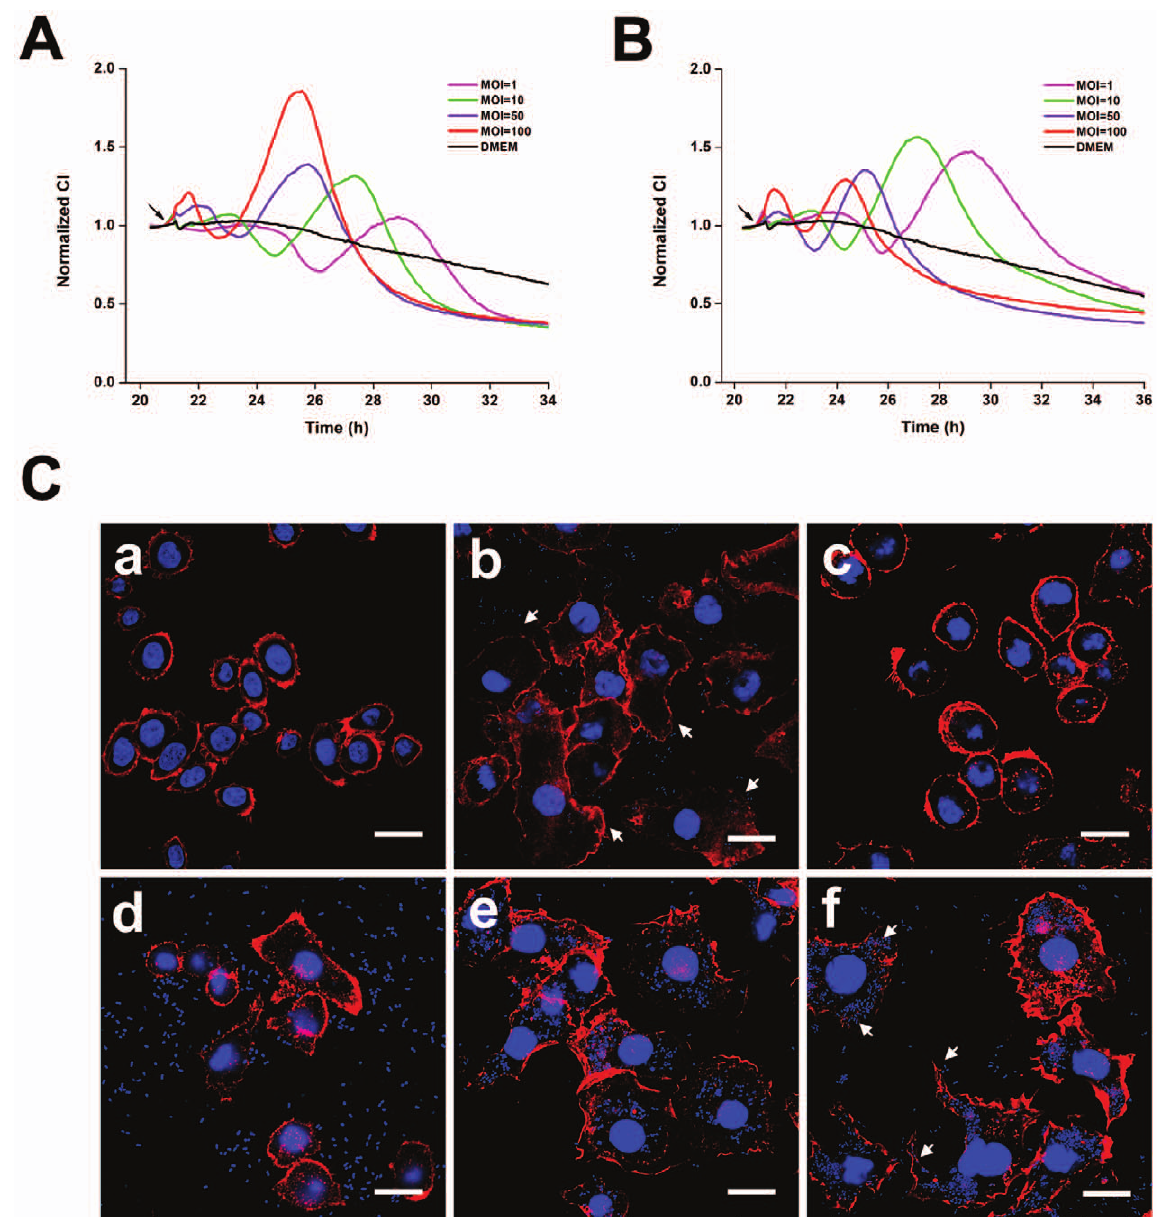
Figure 6. TCRPs and morphological dynamics of macrophages in response to Salmonella infection. J774A.1 cells (30,000 cells per well) were seeded into E-plates. The next day, cells were infected with MOIs 1, 10, 50, or 100 of S. typhimurium (A) or S. entertidis (B). Arrows, bacterial addition. (C) Immunofluorescence of J774A.1 macrophages infected with S. typhimurium . (a) Uninfected cells; (b) cells at 45 min post-infection. Arrows, cytoskeleton and membrane ruffling. (c, d) Cells at 1.5 h and 3 h post-infection. Most cells regained its normal architecture. (e, f) Cells at 5 h and 7 h post-infection. Membrane ruffling and Salmonella -containing vacuoles (SCV) are shown. Arrows, membrane rupture and release of intracellular bacteria. Representative curves are an average of four replicate